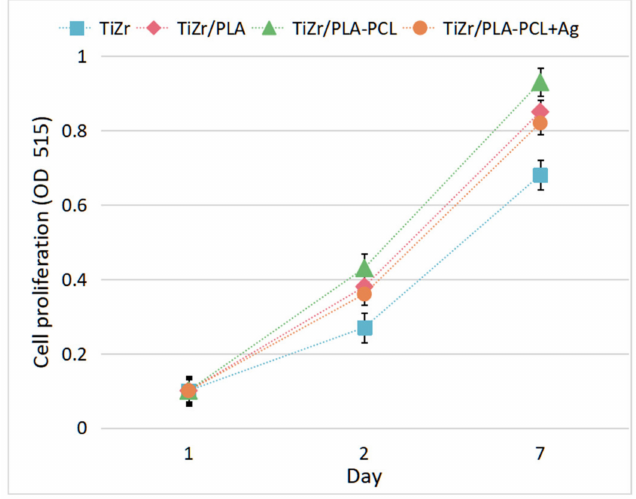
Figure 7. MC3T3-E1 cells proliferation on TiZr and coated